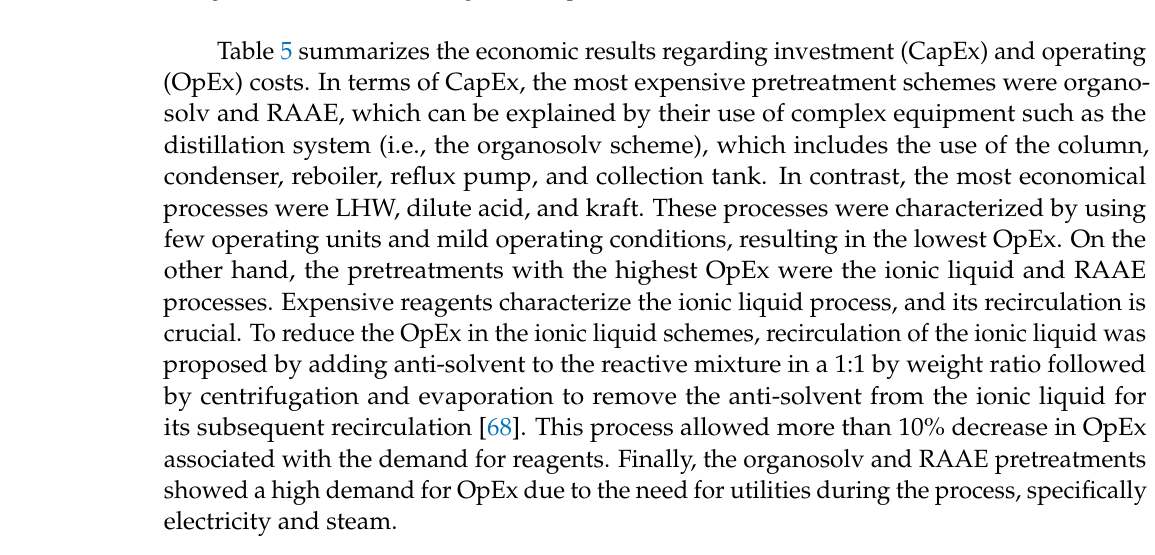
Table 5. Economic assessment of pretreatments to produce different lignocellulosic